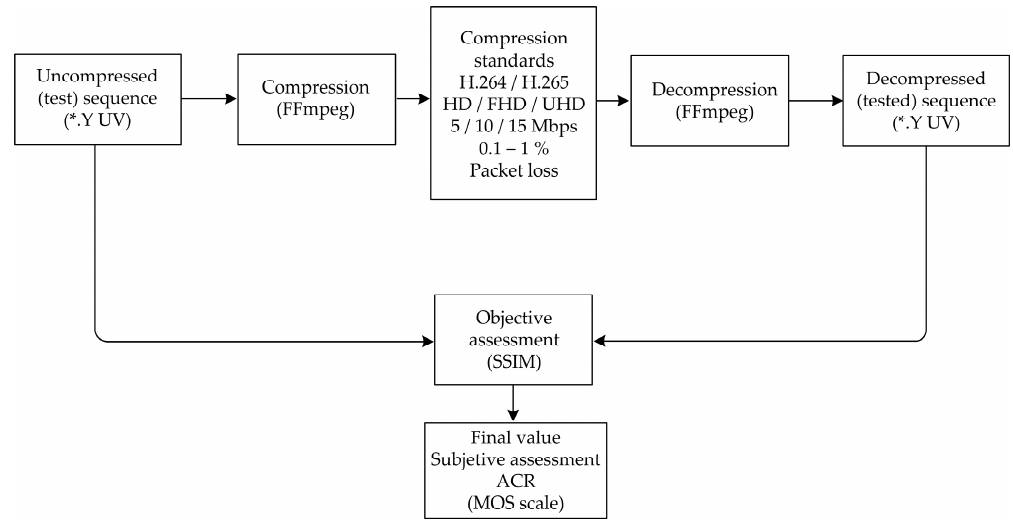
Figure 4. The whole procedure of creation and evaluation of testing video sequences.